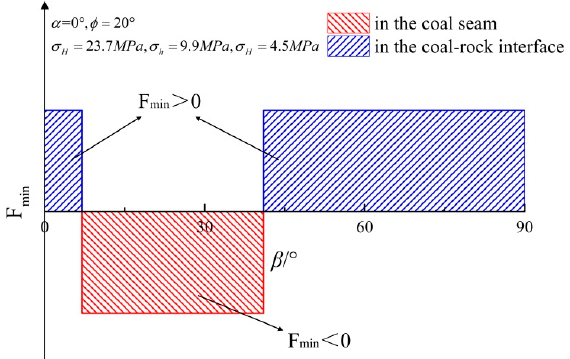
Figure 10. Graph showing the variation in theoretical fracture initiation location. For values of β between 7° and 41°, F min is negative and fractures will initiate in the coal seam. For all other values of β , F min is positive and fractures initiate in the coal ‐ rock interface.